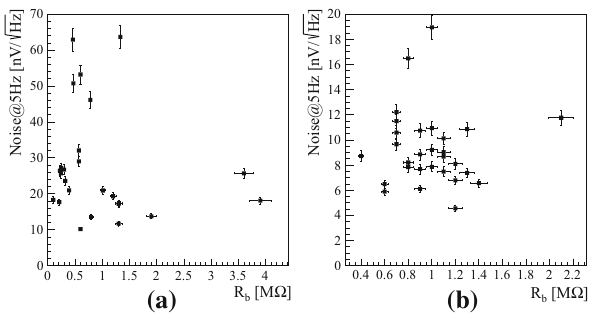
Fig. 20 Detectors RMS noise at 5 Hz as a function of the Ge-NTD dynamic impedance for ZnSe ( a ) and LD ( b